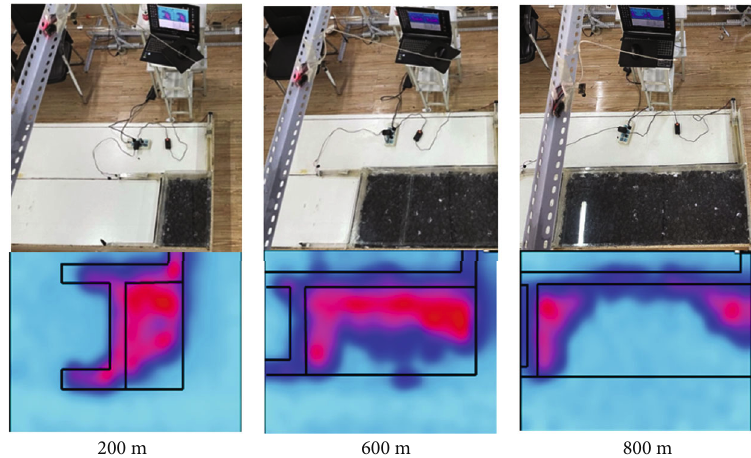
Figure 9: Experimental results at working face advancement positions.